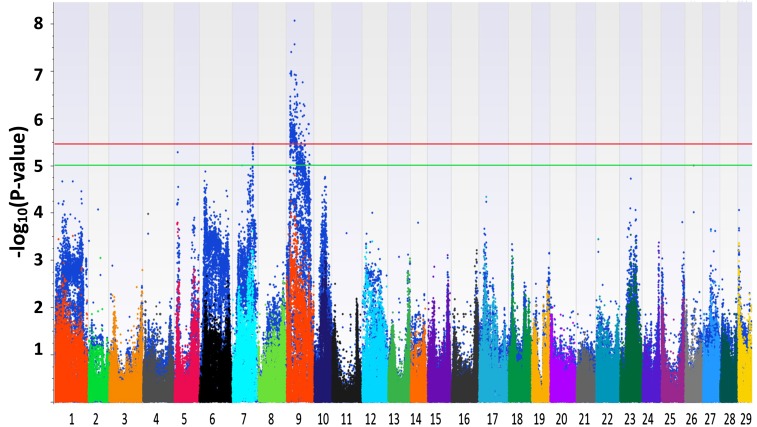
Manhattan plots for head width. The plots in different colors in the front layer were generated from EMMAX (Efficient Mixed-Model Association eXpedited) and the plots in blue in the back layer were generated from QFAM (family-based association test for quantitative traits).